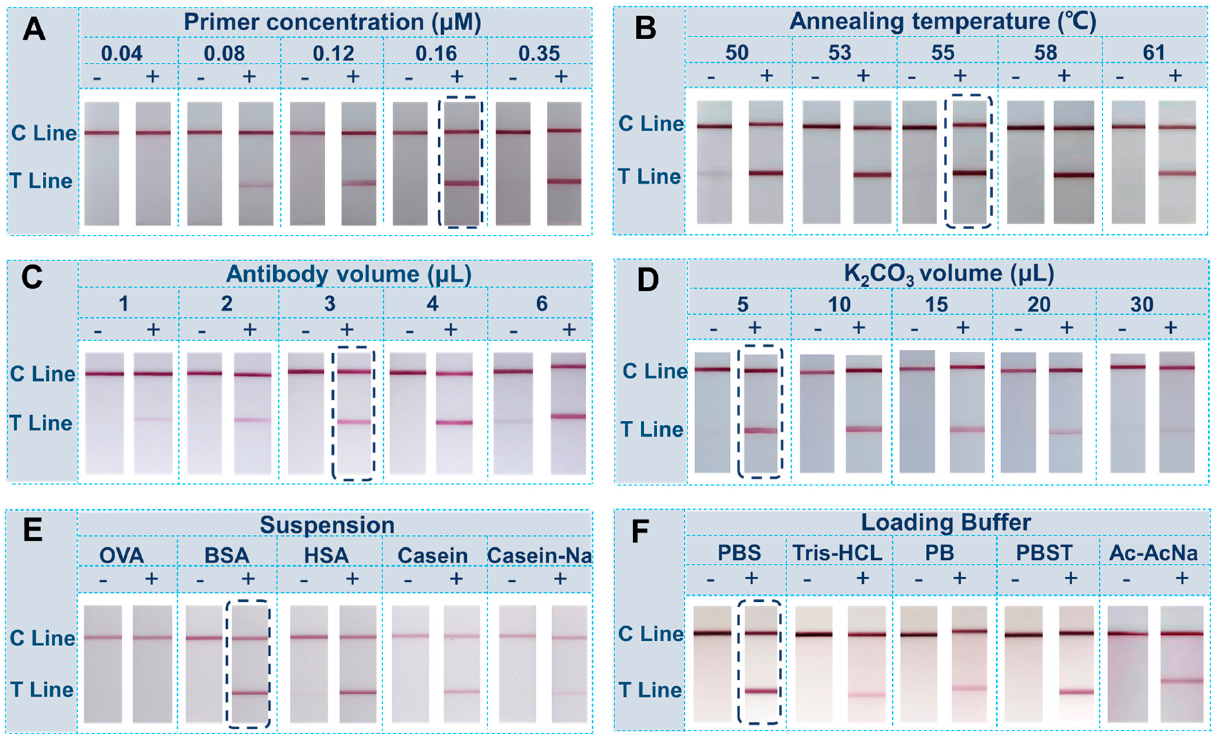
Figure 3. Optimization of experimental parameters: ( A ) Primer concentration (0.04 μ M, 0.08 μ M, 0.12 μ M, 0.16 μ M and 0.35 μ M); ( B ) Annealing temperature (50 °C, 53 °C, 55 °C, 58 °C and 61 °C); ( C ) Volume of antibody for conjugation (1 μ L, 2 μ L, 3 μ L, 4 μ L and 5 μ L 1 mg/mL antibody); ( D ) Volume of K 2 CO 3 for pH adjustment (5 μ L, 10 μ L, 15 μ L, 20 μ L and 30 μ L 0.1M K 2 CO 3 ); ( E ) Suspension species (0.5%OVA, 10% BSA, 10% HSA, 0.5% Casein and 0.5% Casein − Na); ( F ) Categories of loading buffer (10 mM PBS, 10 mM Tris − HCL, 10 mM PB, 10 mM PBT and 10 mM Ac − AcNa)